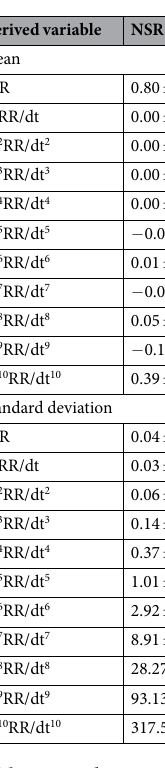
Table 1. Application of the γ -metric for heart rhythm classification. Mean ± standard deviation values for the mean and standard deviation operators applied to the first ten time derivatives of the initial RR time series for comparison of the Normal Sinus Rhythm (NSR, N = 4,500) group with the Atrial Fibrillation (AF, N = 2,900) group, *** p-value < 0.001 by Student’s t-test and the univariate γ NSR / AF value that represents the surface-to- surface algebraic distance between the two 1-dimensional ellipsoids (segments) that correspond to the NSR and AF